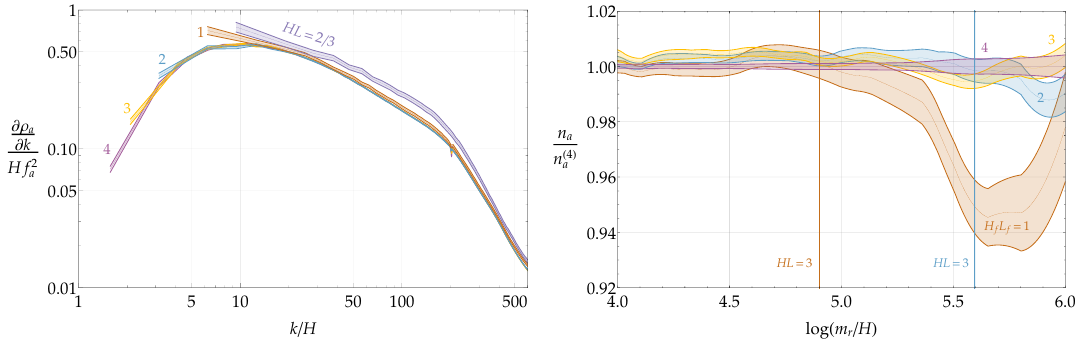
Figure 19 . The spectrum at log( m r =H ) = 6 (left) and axion number density (normalised to the number density calculated in a simulation with the largest box size tested: H f L f = 4) as a function of log( m r =H ) (right) for di(cid:11)erent (cid:12)nal numbers of Hubble patches at the end of the simulation. Error bars represent statistical errors in the average over di(cid:11)erent